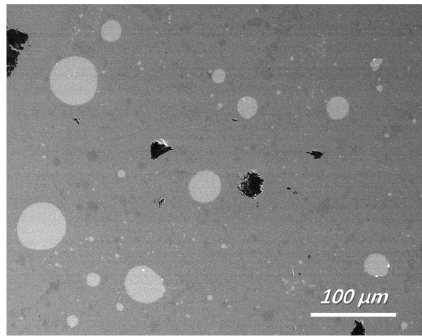
Table 4. Size distribution of silicon droplets/mm 2